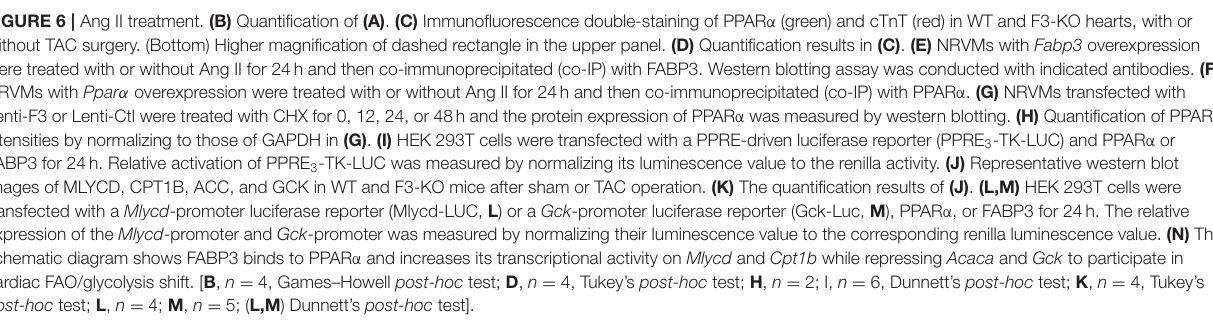
FIGURE 6 | Ang II treatment. (B) Quantification of (A) . (C) Immunofluorescence double-staining of PPAR α (green) and cTnT (red) in WT and F3-KO hearts, with or without TAC surgery. (Bottom) Higher magnification of dashed rectangle in the upper panel. (D) Quantification results in (C) . (E) NRVMs with Fabp3 overexpression were treated with or without Ang II for 24h and then co-immunoprecipitated (co-IP) with FABP3. Western blotting assay was conducted with indicated antibodies. (F) NRVMs with Ppar α overexpression were treated with or without Ang II for 24h and then co-immunoprecipitated (co-IP) with PPAR α . (G) NRVMs transfected with Lenti-F3 or Lenti-Ctl were treated with CHX for 0, 12, 24, or 48h and the protein expression of PPAR α was measured by western blotting. (H) Quantification of PPAR α intensities by normalizing to those of GAPDH in (G) . (I) HEK 293T cells were transfected with a PPRE-driven luciferase reporter (PPRE 3 -TK-LUC) and PPAR α or FABP3 for 24h. Relative activation of PPRE 3 -TK-LUC was measured by normalizing its luminescence value to the renilla activity. (J) Representative western blot images of MLYCD, CPT1B, ACC, and GCK in WT and F3-KO mice after sham or TAC operation. (K) The quantification results of (J) . (L,M) HEK 293T cells were transfected with a Mlycd -promoter luciferase reporter (Mlycd-LUC, L ) or a Gck -promoter luciferase reporter (Gck-Luc, M ), PPAR α , or FABP3 for 24h. The relative expression of the Mlycd -promoter and Gck -promoter was measured by normalizing their luminescence value to the corresponding renilla luminescence value. (N) The schematic diagram shows FABP3 binds to PPAR α and increases its transcriptional activity on Mlycd and Cpt1b while repressing Acaca and Gck to participate in cardiac FAO/glycolysis shift. [ B , n = 4, Games–Howell post-hoc test; D , n = 4, Tukey’s post-hoc test; H , n = 2; I, n = 6, Dunnett’s post-hoc test; K , n = 4, Tukey’s post-hoc test; L , n = 4; M , n = 5; ( L,M ) Dunnett’s post-hoc